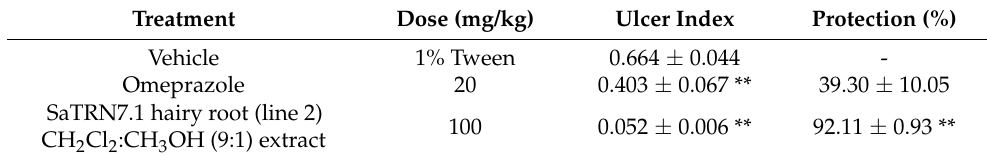
Table 3. Effect gastroprotector of dichloromethane-methanol extract from Sphaeralcea angustifolia hairy root against ethanol-induced gastric lesions in